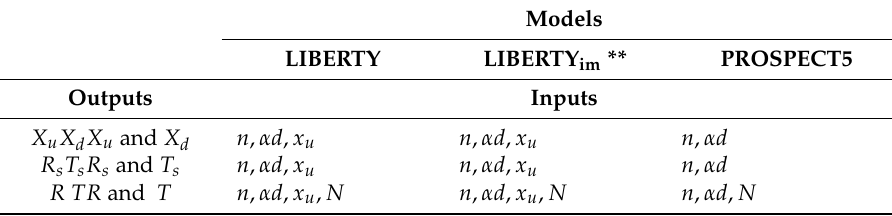
Table 4. Inputs for three models